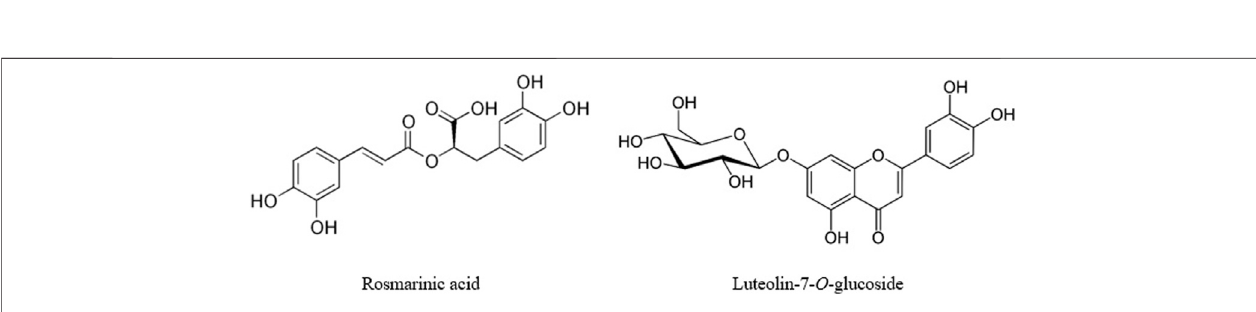
FIGURE 3 | Structural formulas of the predominant polyphenols of the